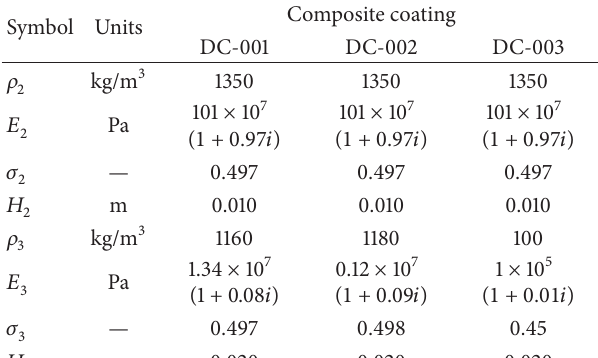
Figure 2: Sound power radiated by the system, compared with [17] ( 𝐻 1 = 9 mm, 𝐻 2 = 0, 𝐻 3 = 50mm, 𝜌 3 = 600 kg/m 3 , 𝐸 3 = 7.2(1 + = 0.38 ). 0.65𝑖) × 10 5 Pa, and 𝜎 3